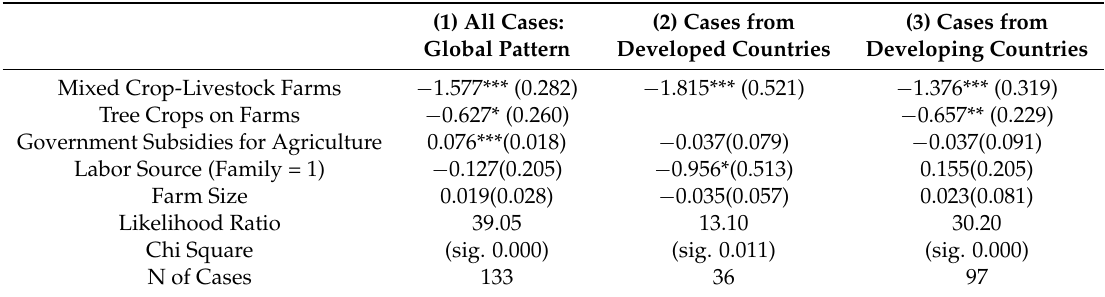
Table 3. Variations in sustainable agriculture practices across farm types: Ɓ coefficients from generalized linear models † .